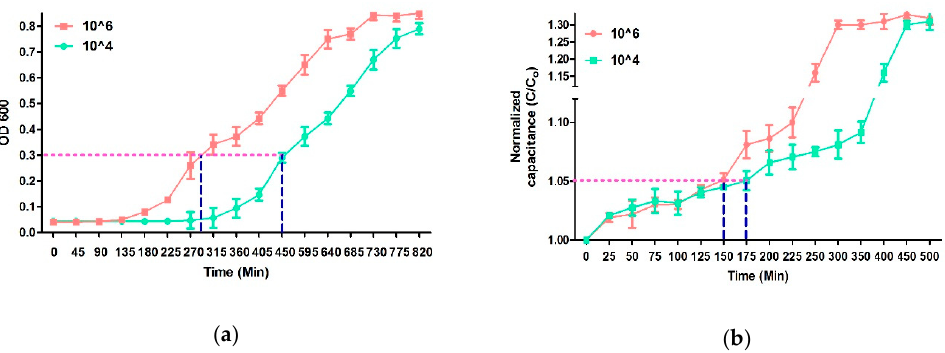
Figure 1. The graphs represent the bacterial growth kinetic analysis of 10 6 and 10 4 CFU/mL E. coli by ( a ) the change in optical density at 600 nm with time and ( b ) the change in normalized capacitance with time.